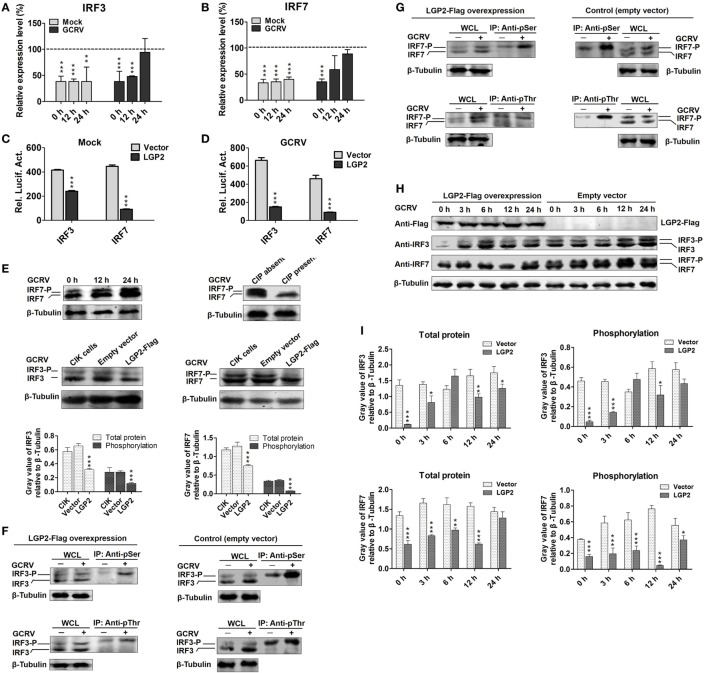
Laboratory of genetics and physiology 2 (LGP2) suppresses interferon regulatory factor 3 (IRF3) and IRF7 signal activation via downregulating their synthesis and phosphorylation. (A,B) LGP2 overexpression inhibits the transcriptions of IRF3 and IRF7. mRNA levels of IRF3 and IRF7 were measured by qRT-PCR in LGP2-Flag and empty vector stable transfected C. idella kidney (CIK) cells at 12 and 24 h post grass carp reovirus (GCRV) infection or mock treatment. Fold change was determined relative to corresponding treatment group in empty vector (dash line). Error bars indicate SD (n = 4). Asterisks indicate significant differences from control (***P < 0.001). (C,D) LGP2 overexpression inhibits the promoter activities of IRF3 and IRF7. FHM cells were cotransfected with 300 ng of LGP2-Flag, 30 ng of pRL-TK, and 300 ng of IRF3pro-luc or IRF7pro-luc plasmids. At 16 h post-transfection, the cells were infected with or without GCRV for 24 h, and then they were collected for luciferase report assay. Error bars indicate SD (n = 4). Asterisks indicate significant differences from control (***P < 0.001). (E) Upper: verification of the phosphorylation band of IRF7 antiserum. CIK cells were infected with GCRV for 12 or 24 h in 6-well plates for Western blotting (WB). A portion of the whole cell lysis (WCL), which was infected with GCRV for 24 h was incubated with or without 10 U of CIP for 30 min. IRF7 was examined by WB with IRF7 antiserum. β-Tubulin was served as an internal control. Middle: LGP2 involves in the inhibition of both IRF3 and IRF7 protein levels. CIK cells, empty vector, and LGP2-Flag-transfected cells were infected with GCRV for 12 h, and the cells lysate was used for WB. The histograms (below) display the relative expression levels, which were quantified by using ImageJ software. Error bars indicate SD (n = 3). Asterisks indicate significant differences from control (***P < 0.001). (F,G) LGP2 overexpression inhibits GCRV-induced IRF3 and IRF7 Ser and Thr phosphorylation. LGP2-Flag and empty vector stable transfected CIK cells were seeded in 10 cm2 dishes for GCRV infection. At 24 h post-GCRV infection, the cells were lysed for immunoprecipitation (IP) with anti-pSer and anti-pThr Abs (Ab), respectively. The IP samples and WCL were subjected to immunoblotting (IB) with anti-IRF3 and anti-IRF7 antiserum, respectively. (H) LGP2 overexpression represses the protein and phosphorylation levels of IRF3 and IRF7. LGP2-Flag and empty vector stable transfected CIK cells were infected with GCRV and samples were collected at 0, 3, 6, 12, and 24 h postinfection. WCL was subjected to IB with IRF3, IRF7, and β-Tubulin Ab, respectively. (I) The relative protein expression levels were quantified by using ImageJ software. Error bars indicate SD (n = 3). Asterisks indicate significant differences from control (*0.01 < P < 0.05; **0.001 < P < 0.01; ***P < 0.001).